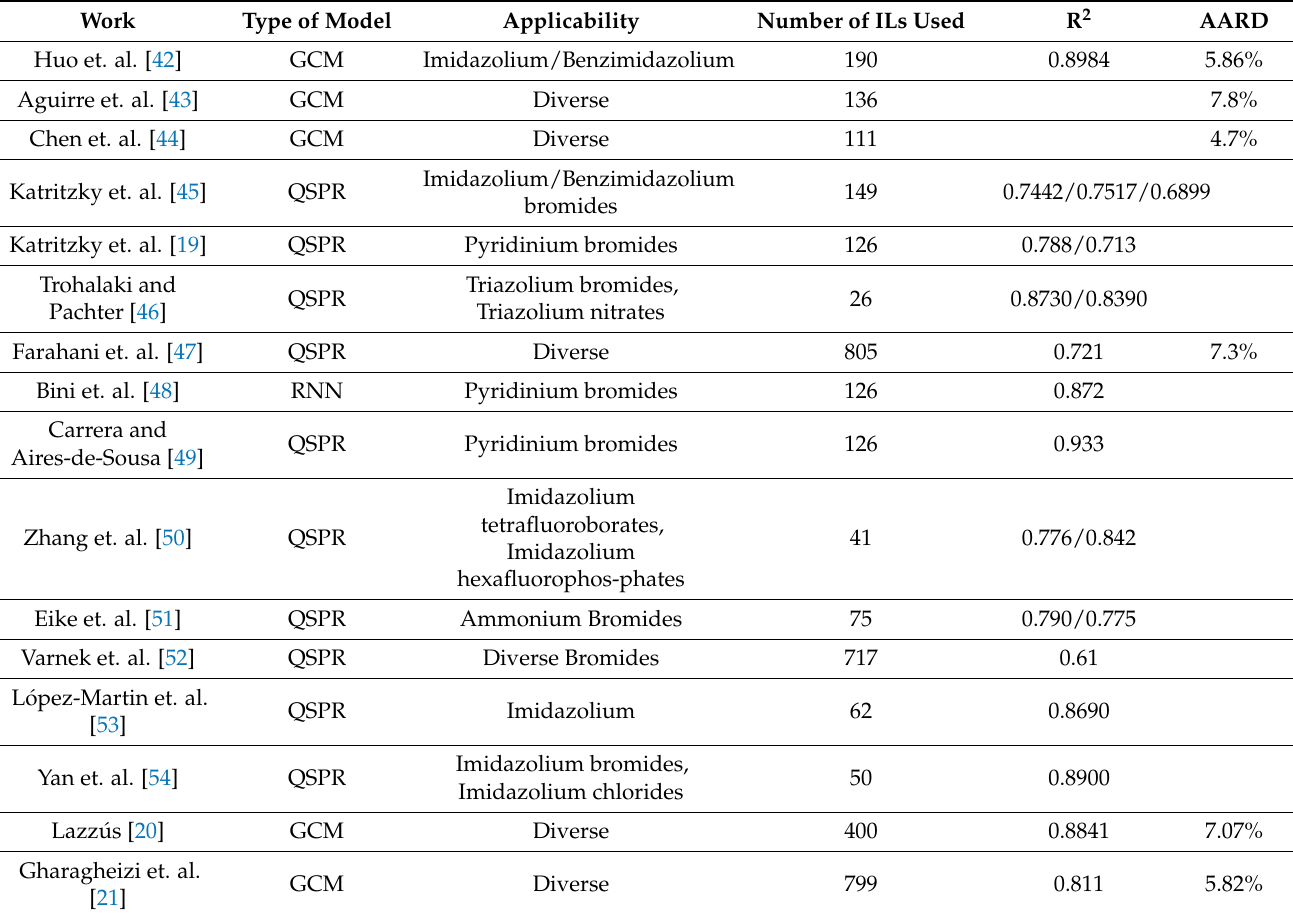
Table 1. Summary of existing models for IL melting point